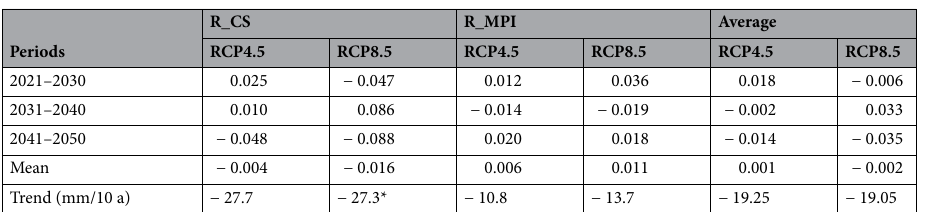
Table 8. Changes and trends of precipitation from R_CS and R_MPI under the RCP4.5 and RCP8.5 scenarios in different periods. *indicates a significant value at the 0.01 level. **indicates a significant value at the 0.05